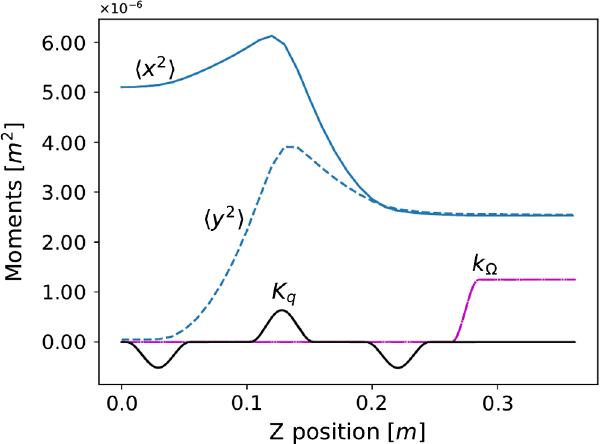
energy.FIG. 5. rms beam size vs longitudinal position for an optimized result that uses non-hardedge magnet profiles. A beam with 5 keV energy and zero current is